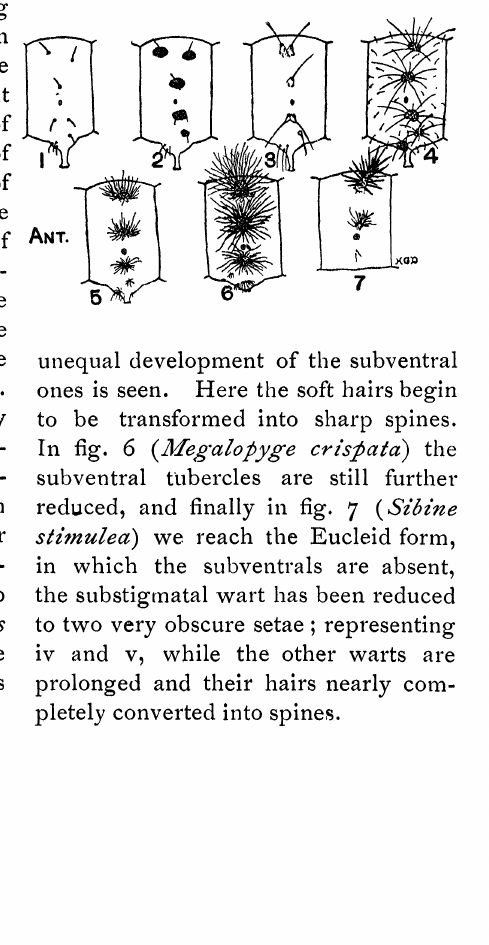
of the moth. an example from the Tineidae of